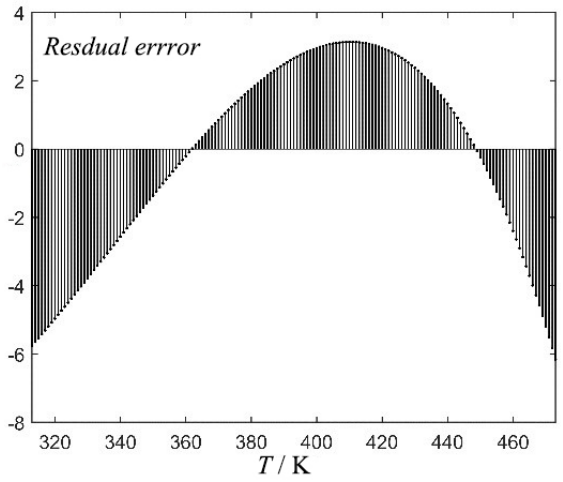
Figure 3. Residuals between fitting and theoretical values.